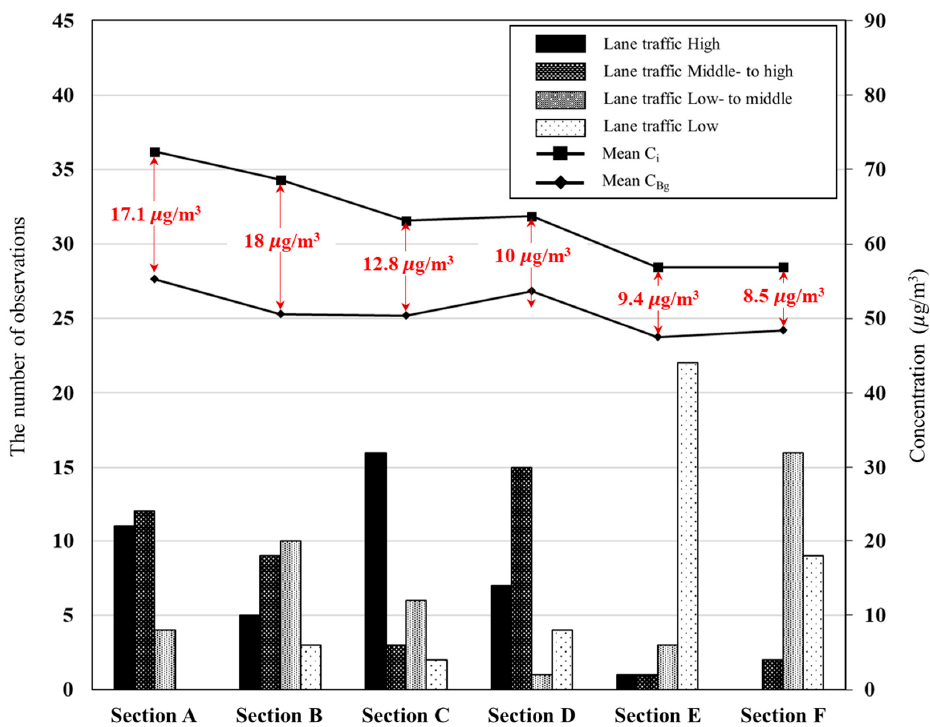
Figure 12. Comparison of the number of lane traffic level type observations and C res concentrations.